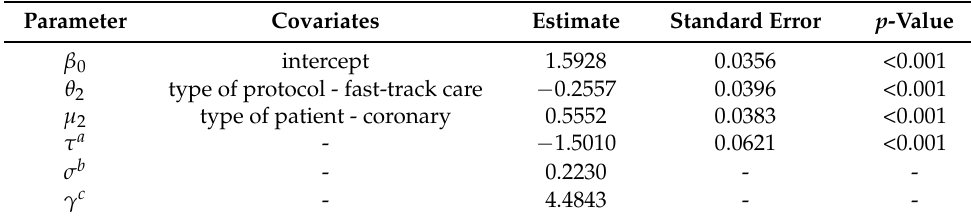
Table 7. Weibull regression model parameter